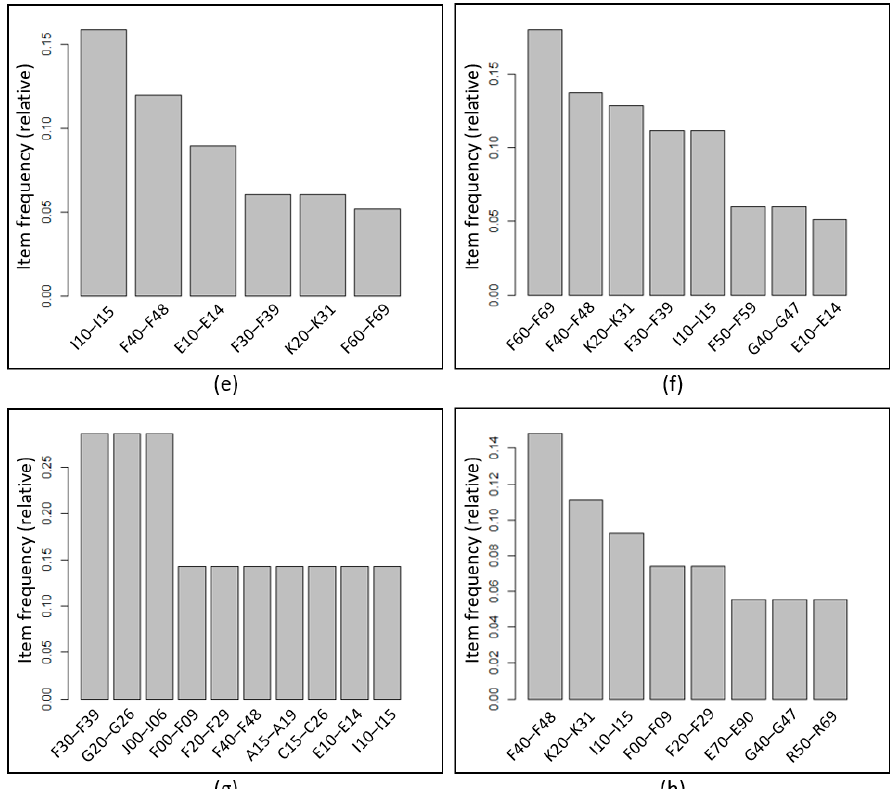
Figure 1. Frequent comorbidities by sub-diagnosis of mood disorders. ( a ) Mood disorders (F30–F39), ( b ) manic episode (F30), ( c ) bipolar affective disorders (F31), ( d ) depressive episode (F32), ( e )